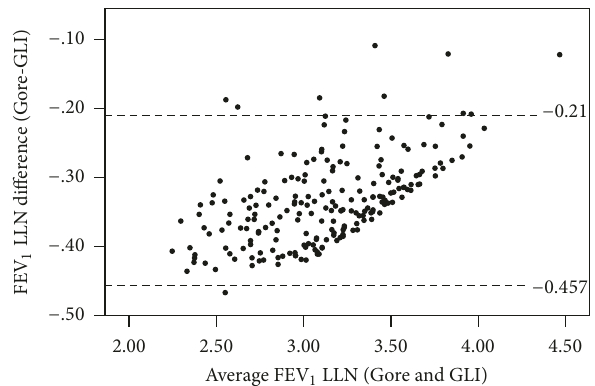
Figure 1: Differences of predicted FVC for Gore compared with GLI illustratingthesmallsystematicdifferenceathighervalues( 𝑁 =212).